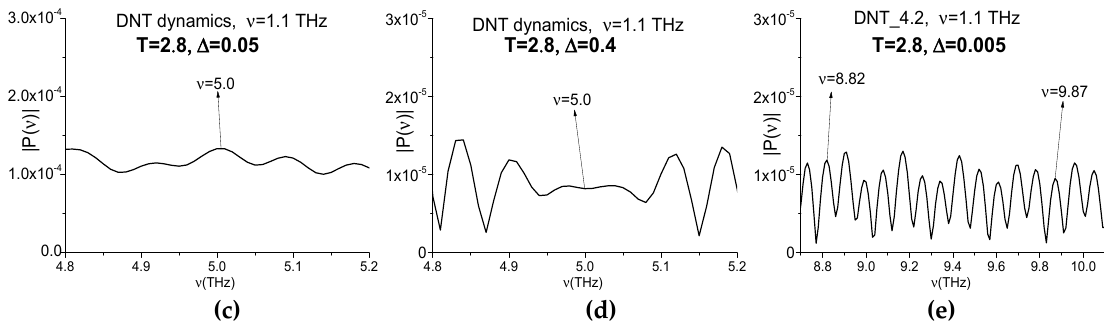
Figure A3 . Spectral line dynamics at the frequency ν = 1.1 THz computed at the window length T = 2.8 ps and at increasing window shift Δ = 0.1, 0.2, 0.4 ps (a), 0.1, 0.05, 0.005 ps (b). Spectra of the spectral line dynamics computed at the window shift Δ = 0.05 ps (c), 0.4 ps (d) and 0.005 ps (e). The similar result occurs for the frequency ν = 4.95 THz, which spectral line dynamics are depicted in Figure A4 computed at the window shift Δ = 0.005 ps (a) and 0.4 ps (b). The magnified view of them is also depicted in Figure A4 (a), (b). In (a) it contains the small oscillations corresponding to the higher frequencies. However, for the window shift Δ = 0.4 ps (b) we see much fewer oscillations.